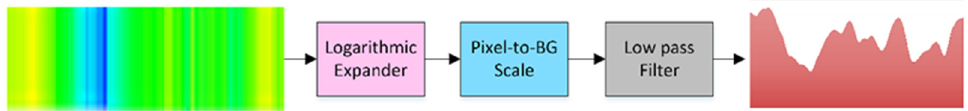
Figure 6. Image to BG translation mechanism depicted with example: 18 h of generated image data is translated into blood glucose time-series.